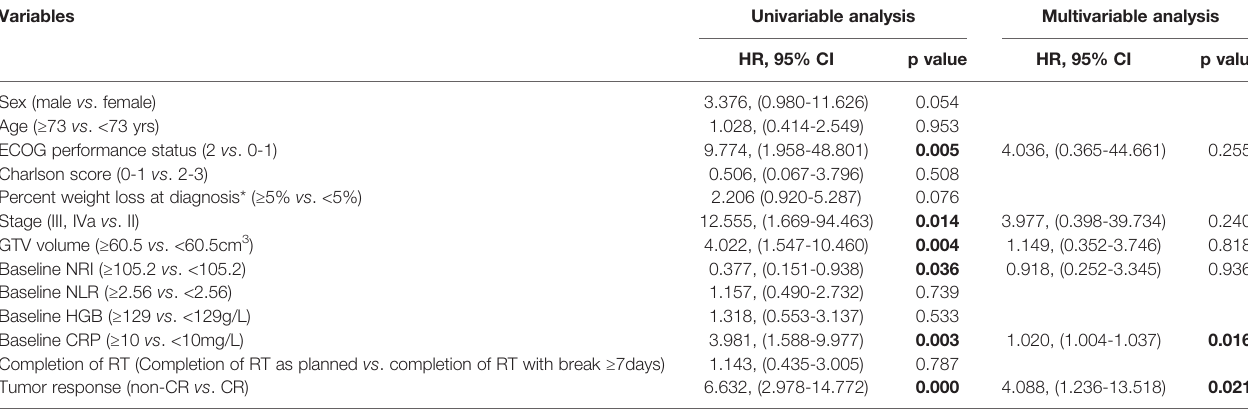
TABLE 4 | Univariable and multivariable analysis of prognostic factors for overall survival. Variables